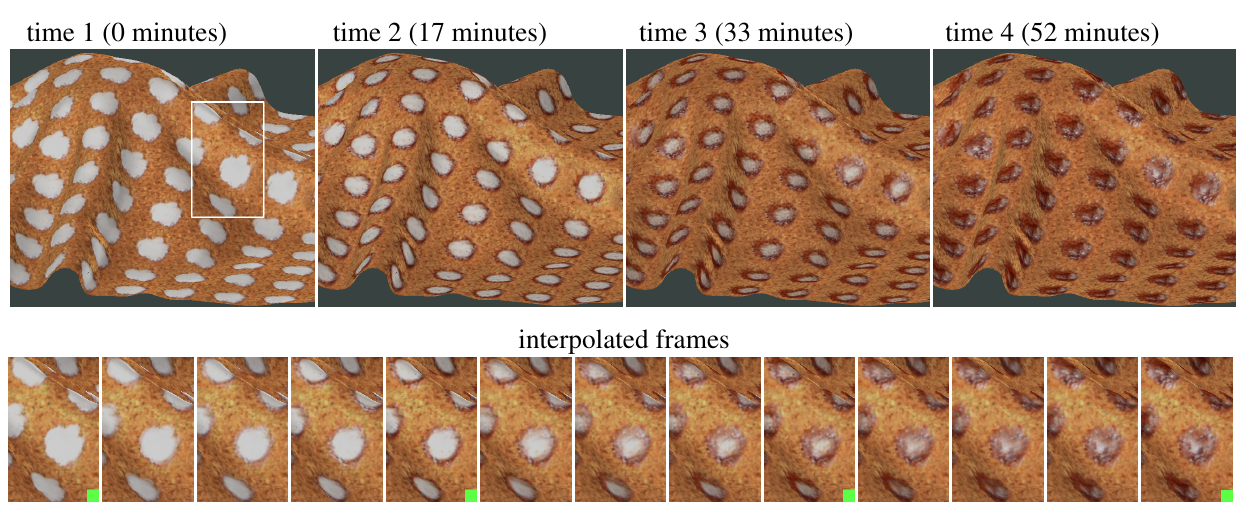
Figure 13. Four measurements of time-varying BTF of glue desiccation (the first row). A complete sequence rendered from interpolated BTFs based on the four measured (marked as green) and nine BTF time-frames interpolated using displacement interpolation (the second row).